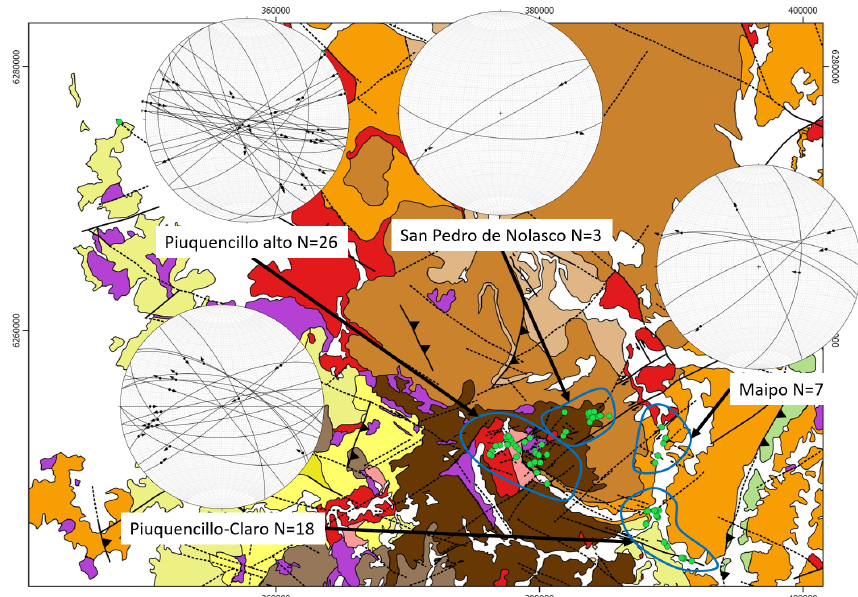
Figure 11. Lower-hemisphere, equal-area projection of the fault planes with kinematic information by sector, showing also the slickenline attitudes and the sense of movement. The geological map in the background was compiled from Rivera and Cembrano (2000), SERNA- GEOMIN (2002), Fock (2005), Fock et al. (2005), Piquer (2015) and this work.